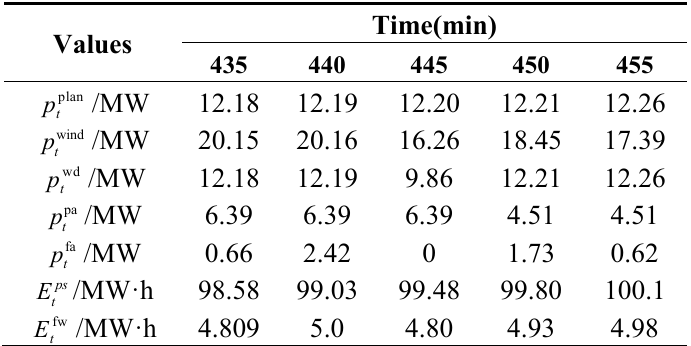
Table 4. Analysis on the cause of the wind